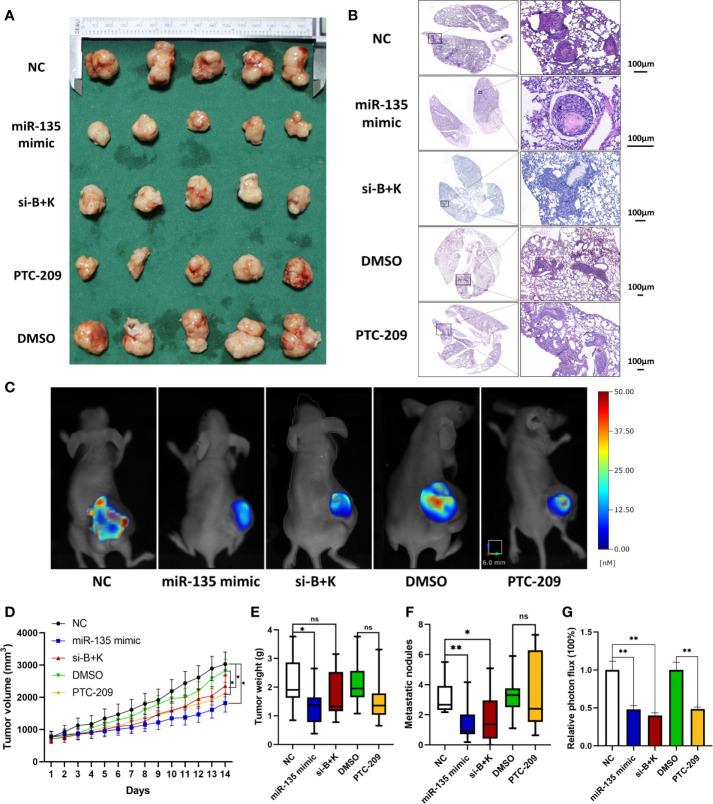
miR-135a, combination therapy, and PTC-209 suppression of mouse OS cell xenograft growth; miR-135a and combination therapy suppression of lung metastasis in vivo. (A) Xenograft photographs. Saos-2 cells were grown and injected into nude mice, and then treat mice with miR-135 mimic, si-B+K, negative control, PTC-209, and DMSO respectively. After 2 weeks, the mice were sacrificed and the xenografts were photographed. (B) HE staining of mouse lung tissues. The mice were sacrificed and the lungs were resected and subjected to tissue processing, embedding, sectioning, and HE staining to quantify tumor cell lung metastasis. Scale bar, 100 μm. (C) Bioimages. Before sacrificed, mice were subjected to bioimaging of the MMPs activity in xenograft tumors with the fluorescence molecular tomography using MMPSense 680. (D) Growth curves of mouse OS cell xenografts. (*p < 0.05; **p < 0.01; n = 10). The significance of differences among groups were analyzed by ANOVA test and the effects were corrected using the Greenhouse–Geisser method in tumor volume because the data did not meet the hypothesis of sphericity (Mauchly’s test statistic W=0.000, p < 0.001). (E) Weight of mouse OS cell xenografts. (*p < 0.05; ns p >0.05; n = 10). (F) The graph of the quantified data of metastatic nodules. (ns p > 0.05; *p < 0.05; **p < 0.01; n = 10). (G) The graph of the quantified data of MMPs activity in xenograft tumors. (**p < 0.01; n = 5). ns, not significant.